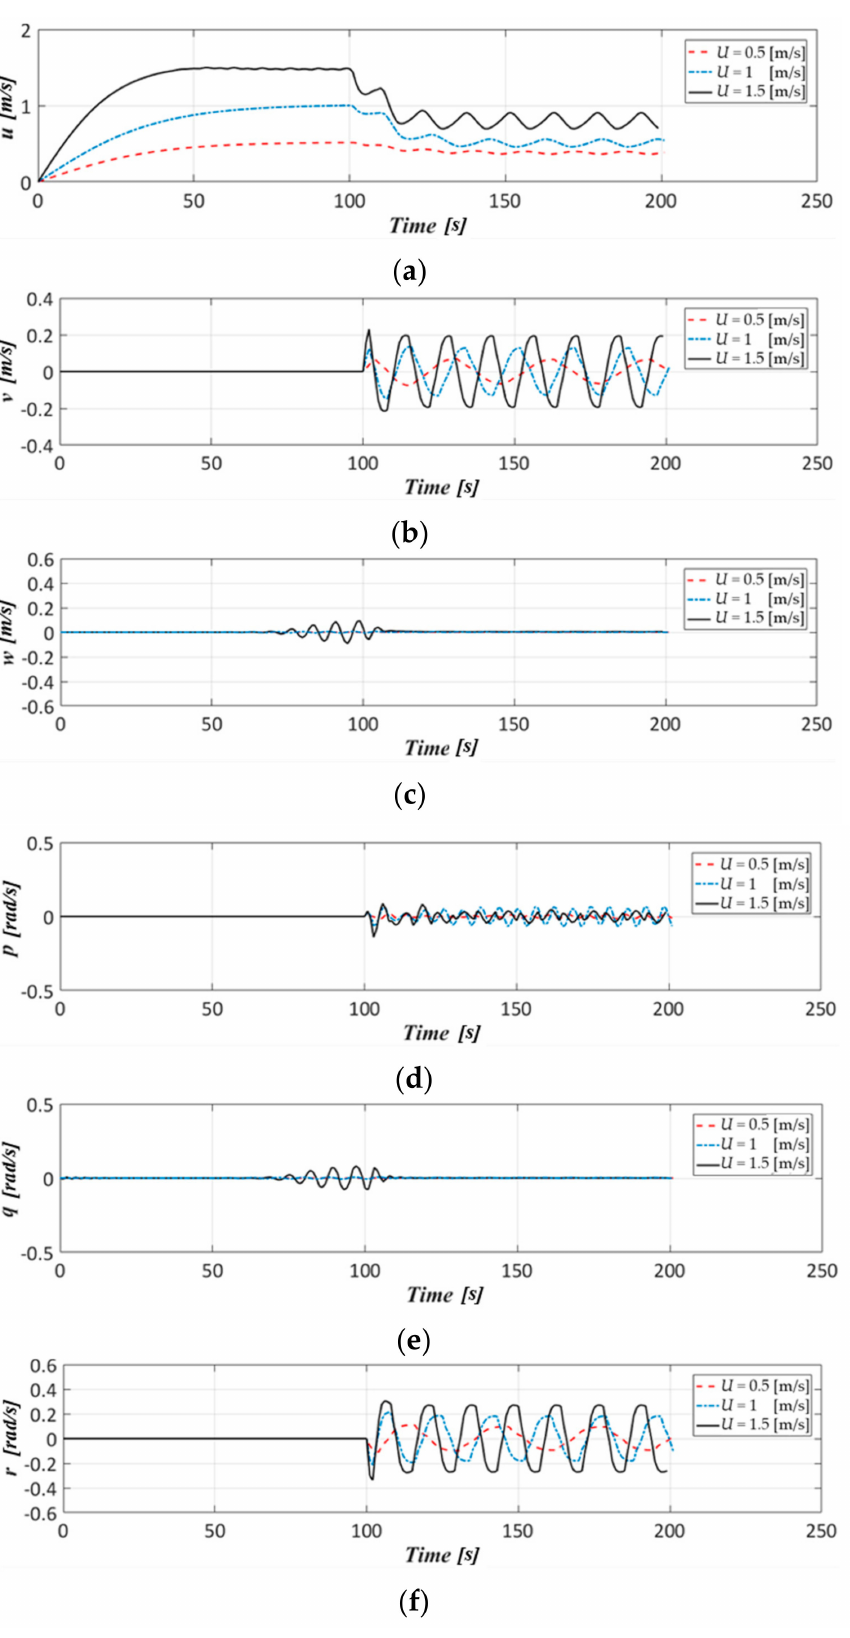
Figure 16. 6-DOF velocity components in the horizontal zigzag test at different sailing speeds. ( a ) Surge rate: u [m/s], ( b ) sway rate: v [m/s], ( c ) heave rate: w [m/s], ( d ) roll rate: p [rad/s], ( e ) pitch rate: q [rad/s], and ( f ) yaw rate: r